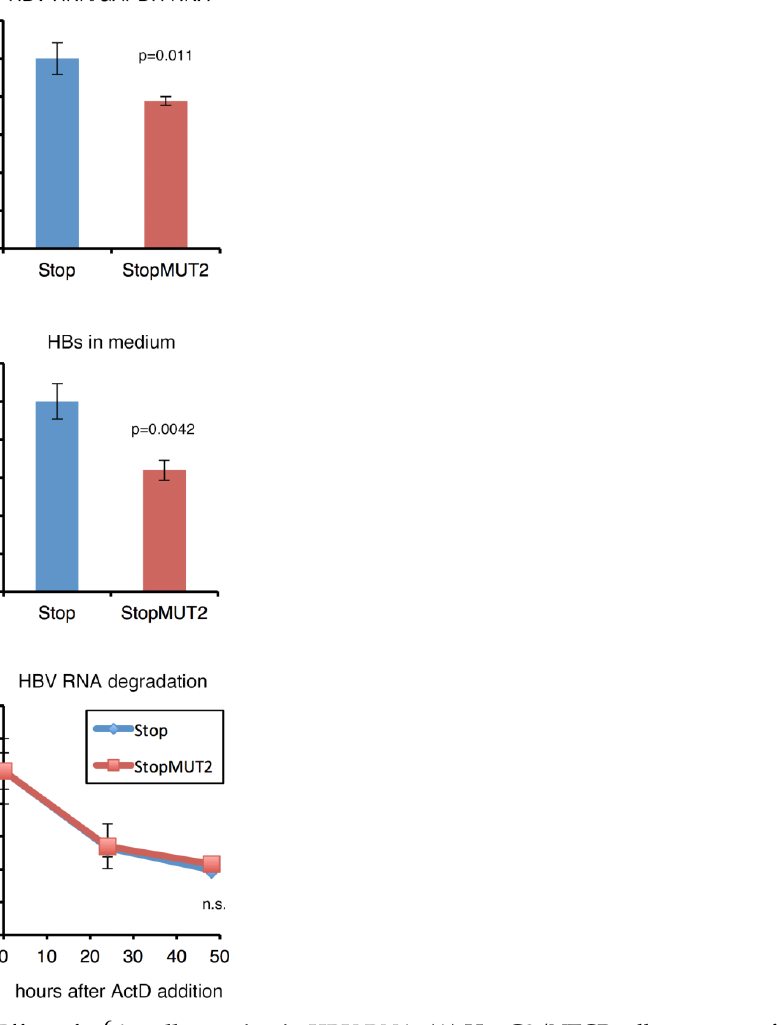
Figure 3. Effect of m 6 A-null mutation in HBV RNA. ( A ) HepG2/NTCP cells were transfected with pUC1.2xHBV (Stop) or pUC1.2xHBV with m 6 A-null mutation (StopMUT2). RNA was harvested after 2 days and qRT-PCR analysis was performed to quantitate RNA levels. ( B ) HepG2/NTCP cells were transfected with the same plasmids. Culture media were collected after 2 days for HBs ELISA. ( C ) HepG2/NTCP cells were transfected with the same plasmids. The next day, actinomycin D (5 µ g/mL) was added, which was followed by incubation for 24 or 48 h. RNA was harvested, which was followed by qRT-PCR analysis. Relative HBV RNA levels are normalized to the levels at 0 h and plotted. Means ± standard deviation (SD) of three independent biological replicates are shown. Student’s t -test was used for the analysis.